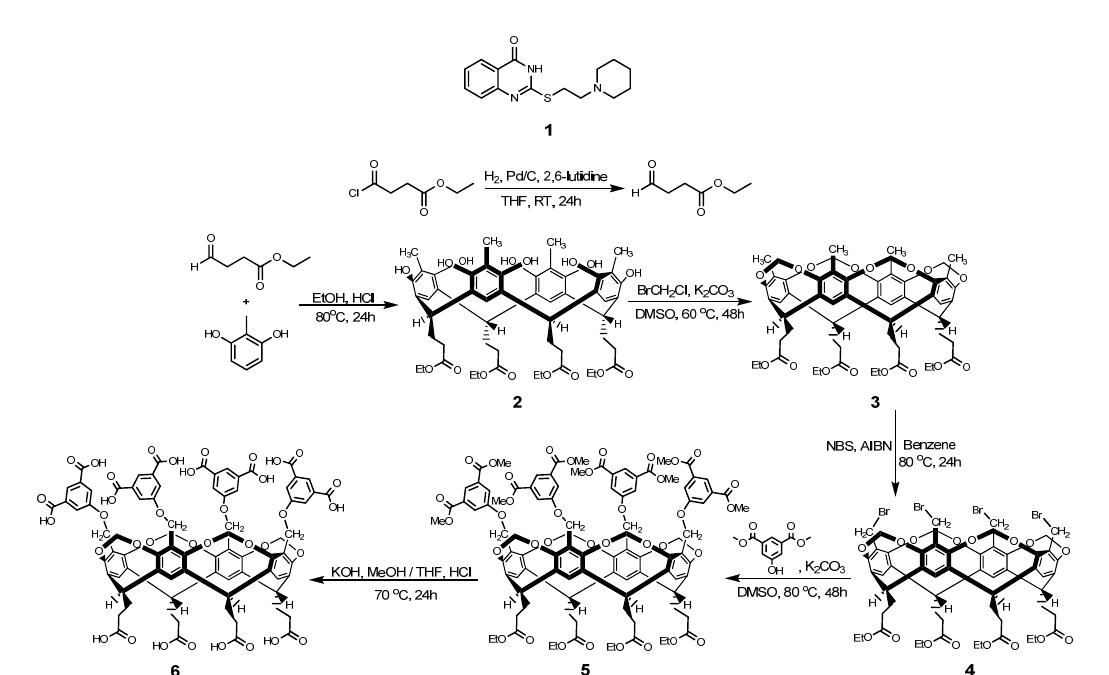
Figure 1. Interaction of 4-quinazolinone ( 1 ) with tetrakis(3,5-dicarboxylatophenoxy)-cavitand ( 6 ) was studied in dimethylformamide and methanol media. Synthesis of the host compound ( 6 ). Fluorescence spectra of the tetrakis(3,5-dicarboxylatophenoxy)-cavitand show decreased